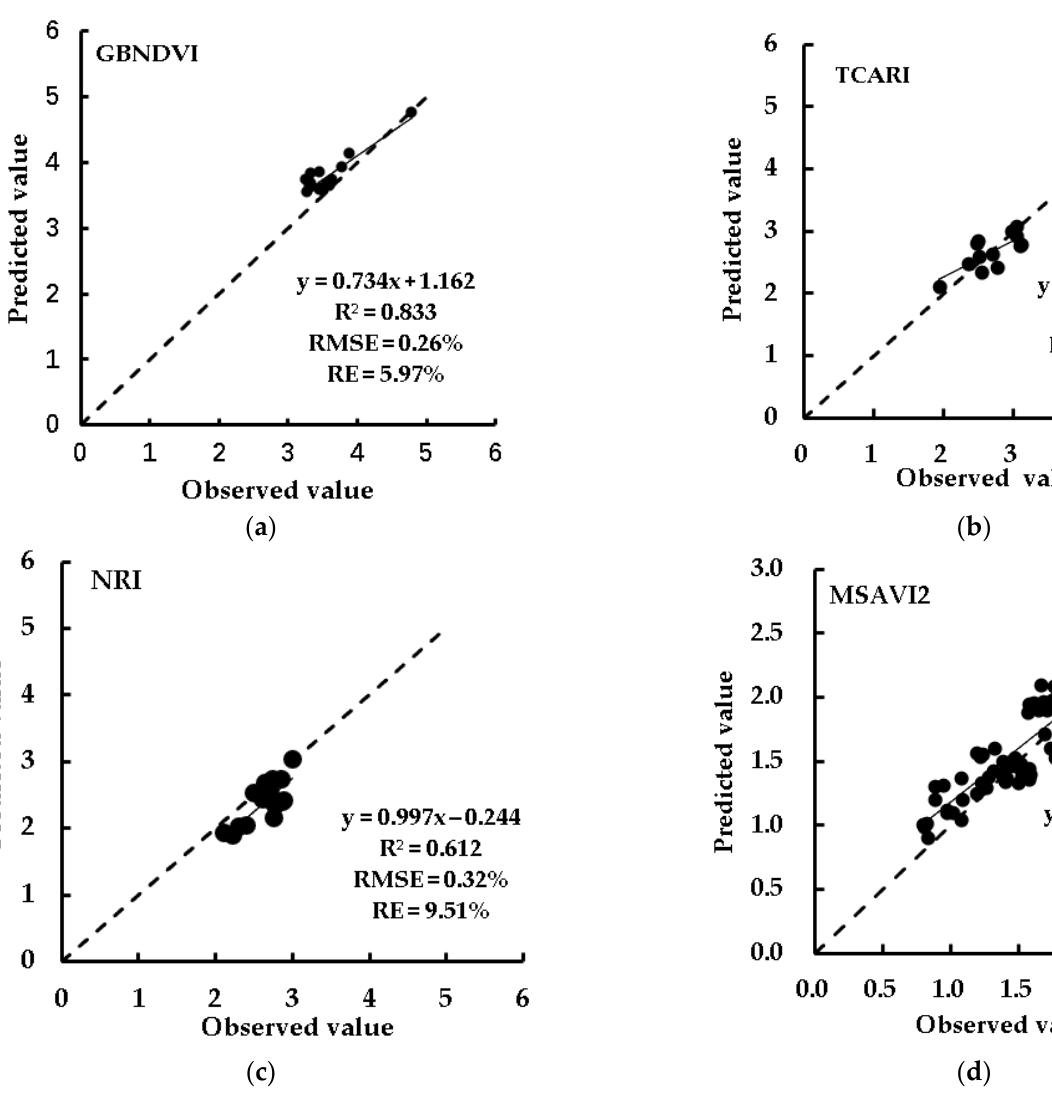
Figure 4. Evaluation results of the UAV multispectral nitrogen diagnosis models of summer maize at the V6 ( a ), V10 ( b ), V12 ( c ), and VT-R6 ( d ) growth